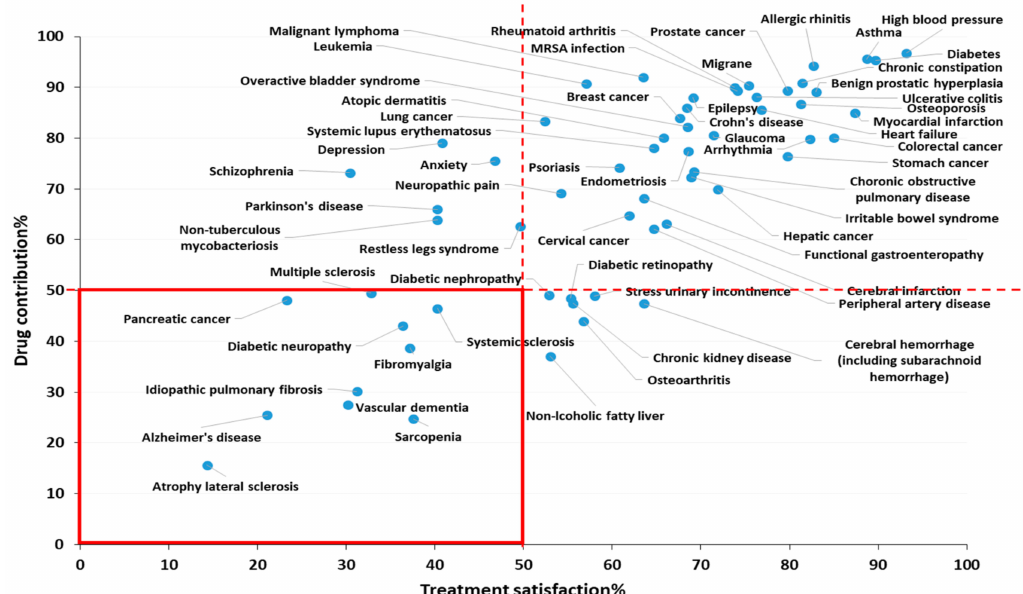
Figure 1. Treatment satisfaction and drug contribution. This figure is based on a medical need survey concerning medical satisfaction and drug contribution for physicians in Japan